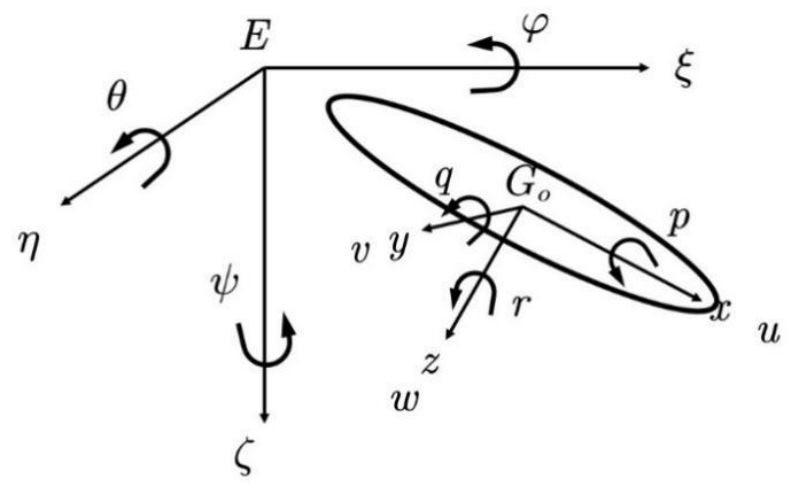
Figure 1. Fixed coordinate system and satellite coordinate system.